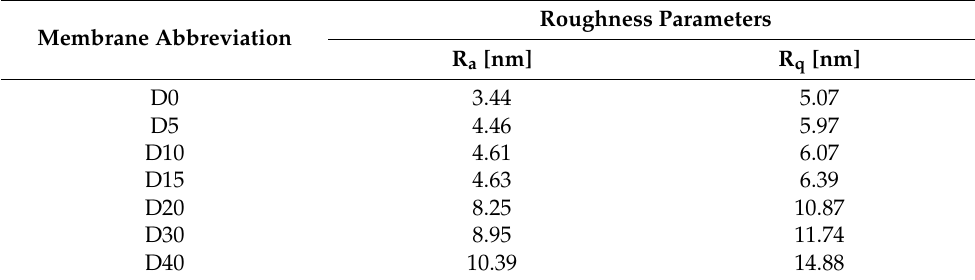
Table 4. Surface roughness parameters of the selective layer surface of TFC and TFN membranes prepared using dynamic technique.